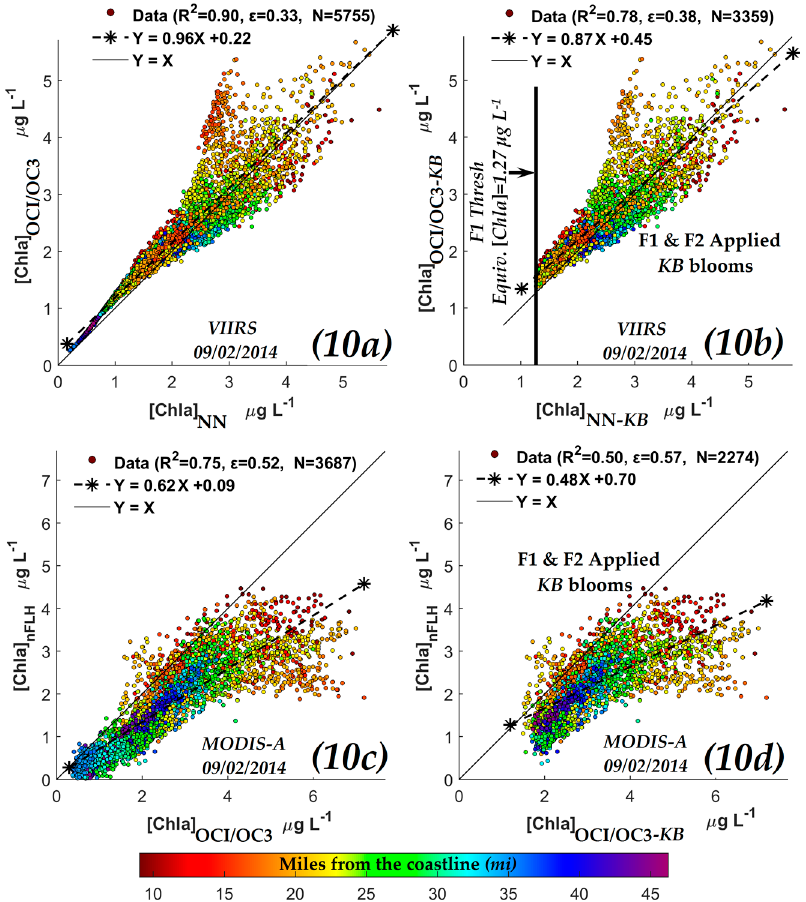
Figure 10. ( a ) Retrieved VIIRS OCI/OC3 [ Chla ] against retrieved MODIS-A NN [ Chla ]; ( b ) Same retrieval as 10a with Filters F1 and F2 applied; ( c ) Retrieved OCI/OC3 [ Chla ] against MODIS-A nFLH equiv. [ Chla ]; ( d ) Same as 10c but with filter F1 & F2 applied. The vertical line shows the NN [ Chla ] KB threshold (F2 mask) consistent with the existence of KB , residual pixels of F1 and F2 masks satisfy both maximum backscatter and minimum NN [ Chla ] and represent values for KB blooms. Color coding of the dots denotes distance to shore, with red being the closest.